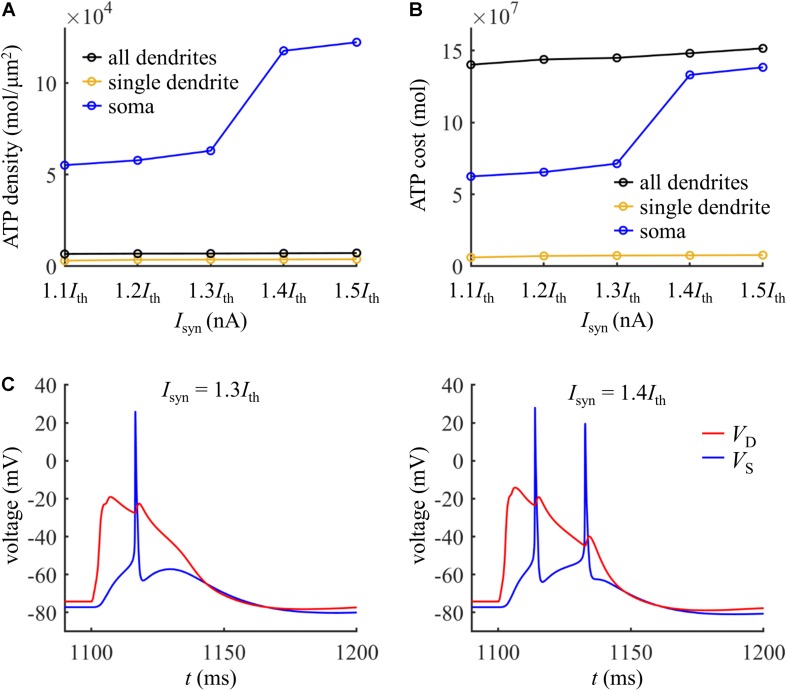
(A) ATP cost per unit membrane area during a Ca2+ spike. (B) Total ATP cost during a Ca2+ spike. The synaptic input was injected in the yellow dendrite, which was Isyn = 1.1Ith, 1.2Ith, 1.3Ith, 1.4Ith, and 1.5Ith. The ATP cost was, respectively, computed in the soma, yellow dendrite, and whole dendrites. (C) Left panel: time courses of somatic voltage VS and dendritic voltage VD at Isyn = 1.3Ith. Right panel: time courses of VS and VD at Isyn = 1.4Ith. The recording site of VS and VD were indicated by the triangles of same color in Figure 9A. IS = 0 nA.